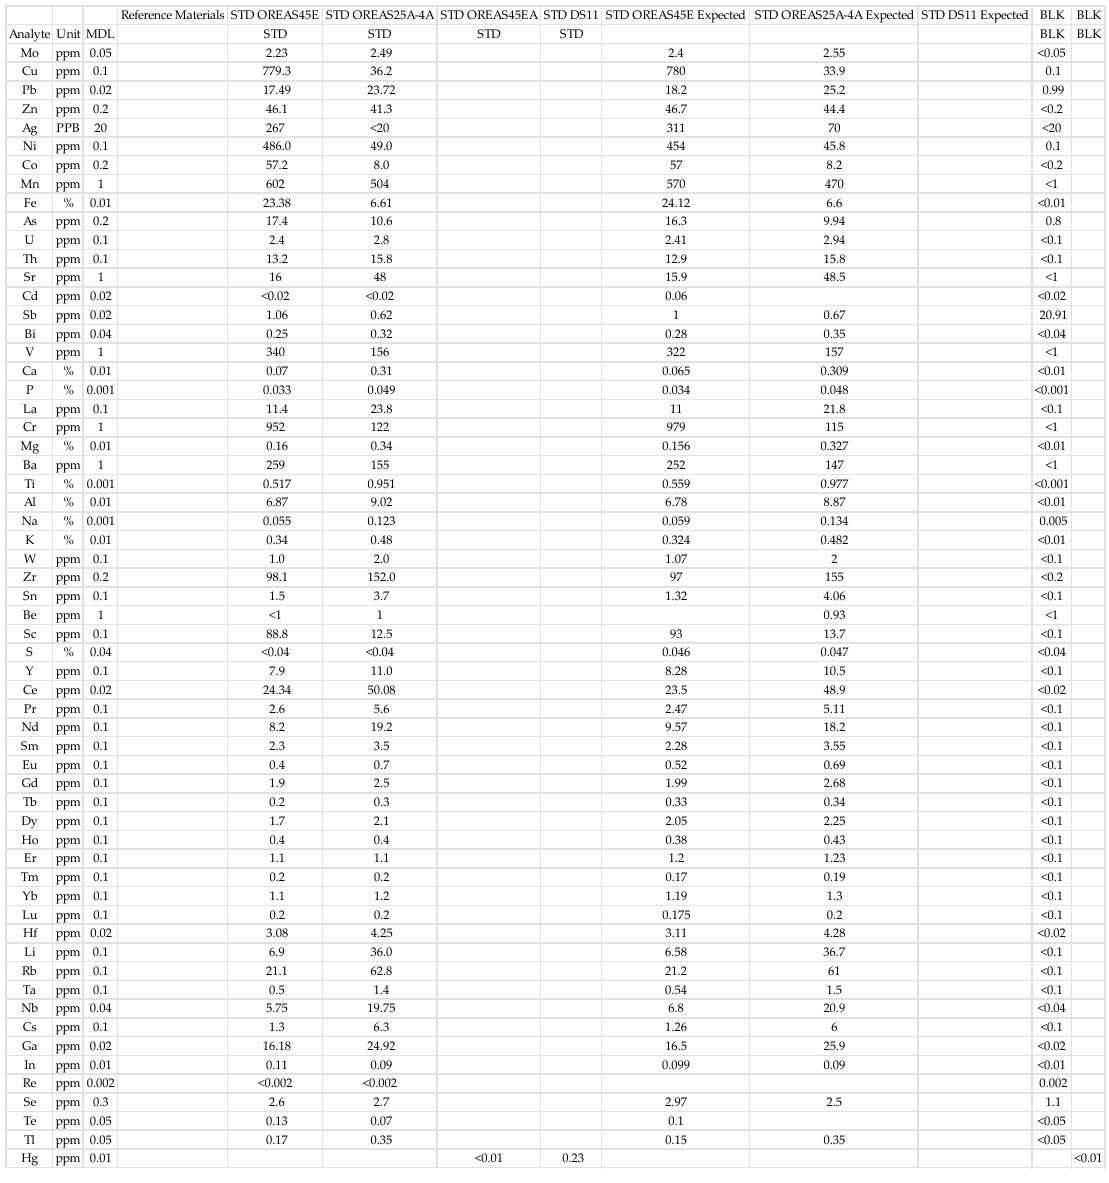
Figure A1. Quality control report of the bulk analyses.